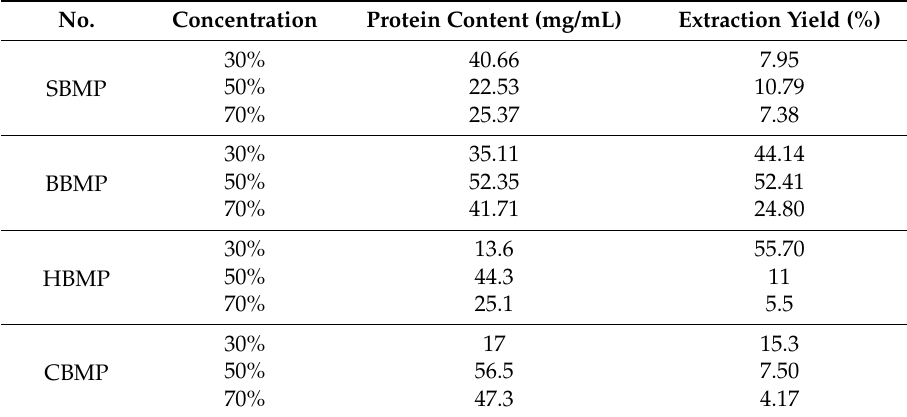
Table 2. Comparison of different BMP by ammonium sulfate fractions.